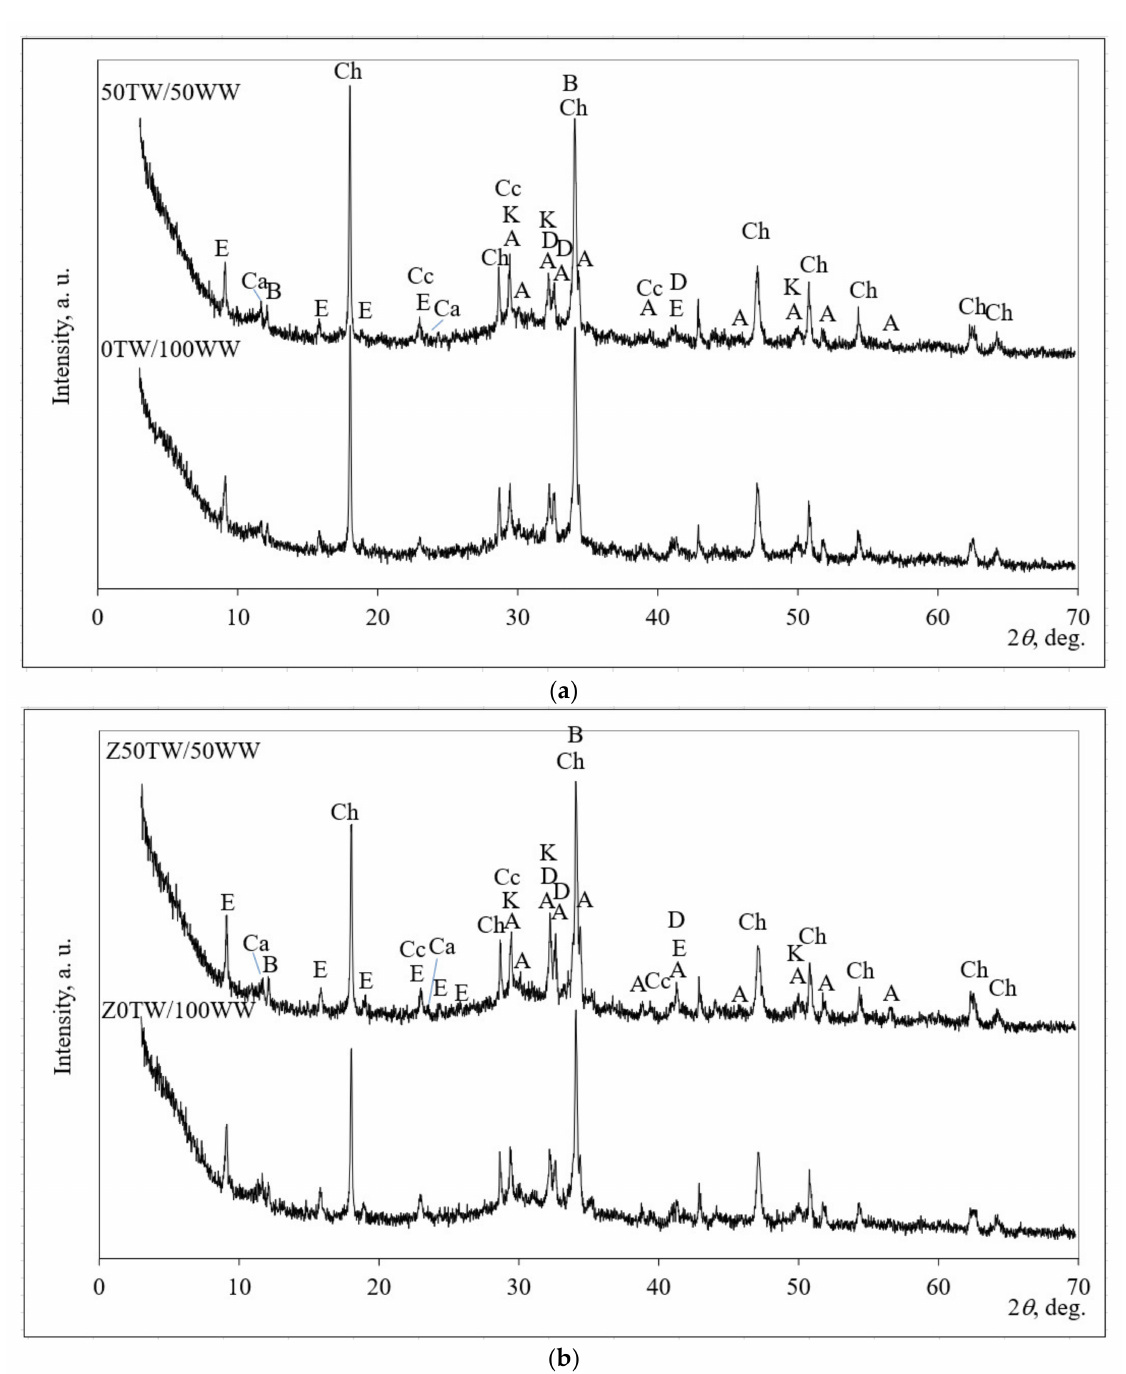
Figure 5. X-ray diffraction (XRD) pattern of hardened cement paste: ( a ) with concrete wash water; ( b ) with the combination of concrete wash water with zeolitic by-product at 28 days of hydration. Notes: Ch—portlandite Ca(OH) 2